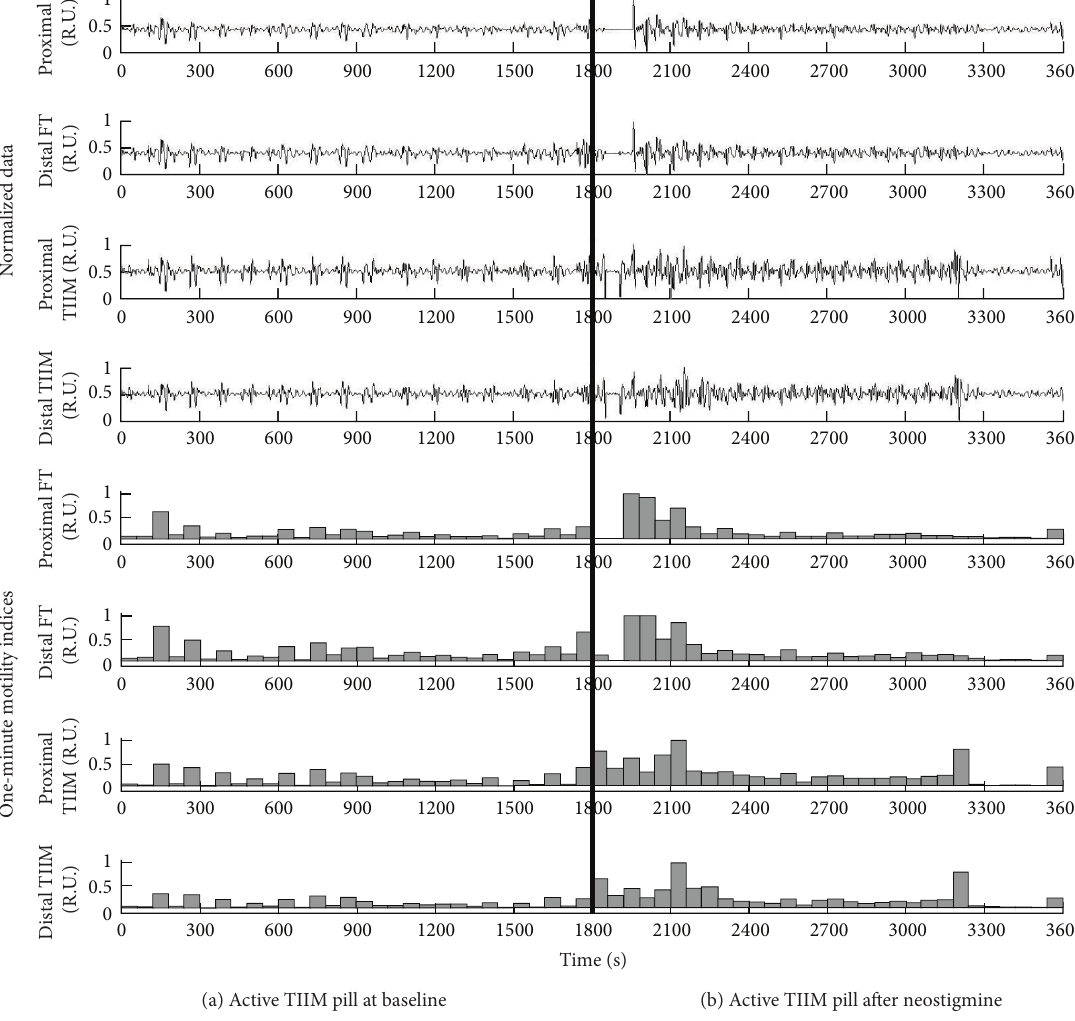
Figure 4: Combined plot of the raw signals and the 1-minute motility indices for an active pill in the baseline state (seconds 0–1800) and after the administration of neostigmine (seconds 1800–3600). The 1-minute duration for the administration of neostigmine is denoted by a thick vertical line.